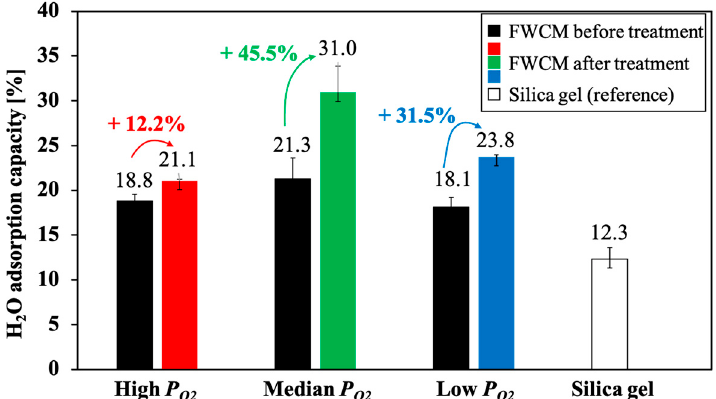
Figure 5. Water adsorption capacities of untreated and vacuum-ultraviolet-treated films of woody carbon material at 20% relative-humidity. Commercial silica-gel desiccant was also evaluated as a reference.